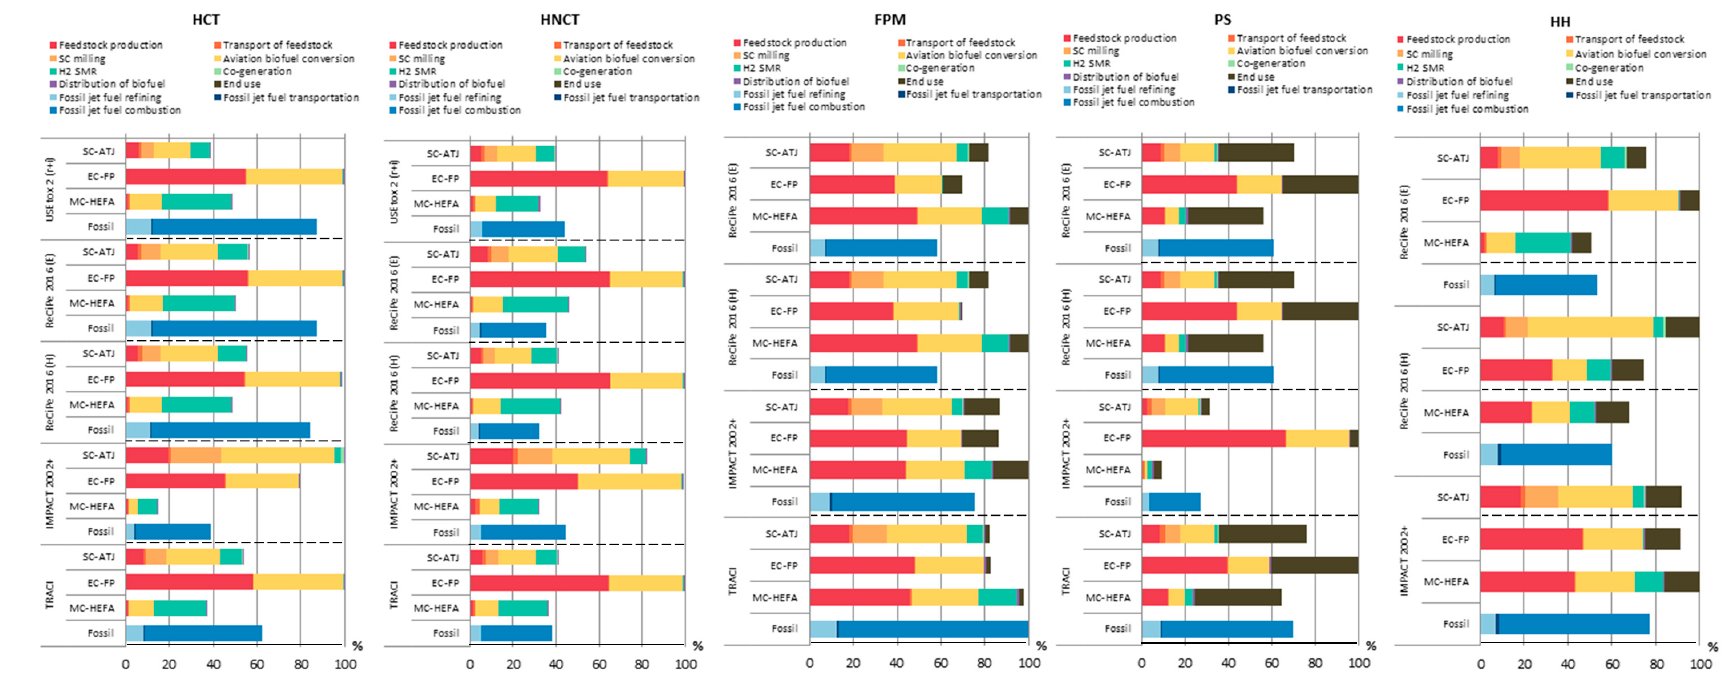
Figure 4. Contribution analysis for each impact category (HCT: human carcinogenic toxicity, HNCT: human non-carcinogenic toxicity, FPM: fine particular matter, PS: Photochemical smog, HH: human health).